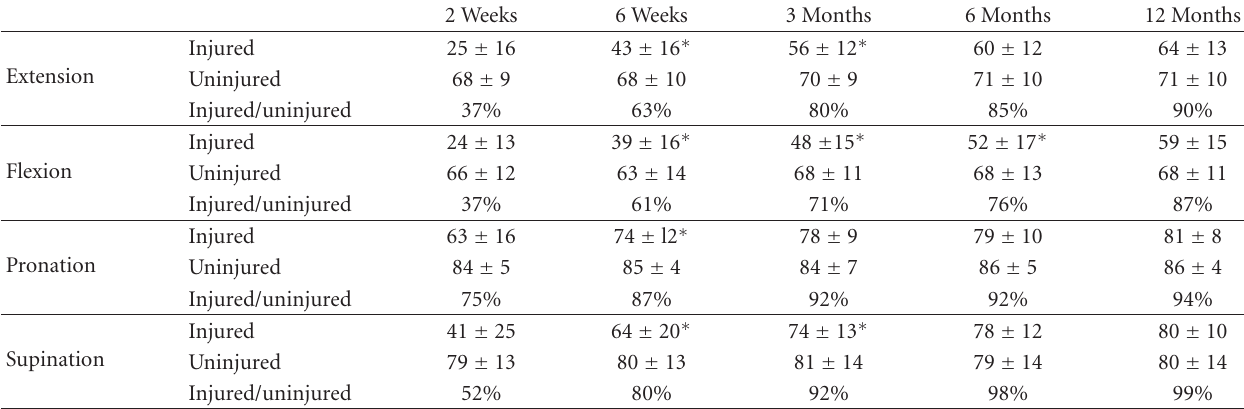
Table 1: Wrist range of motion (degrees ± standard